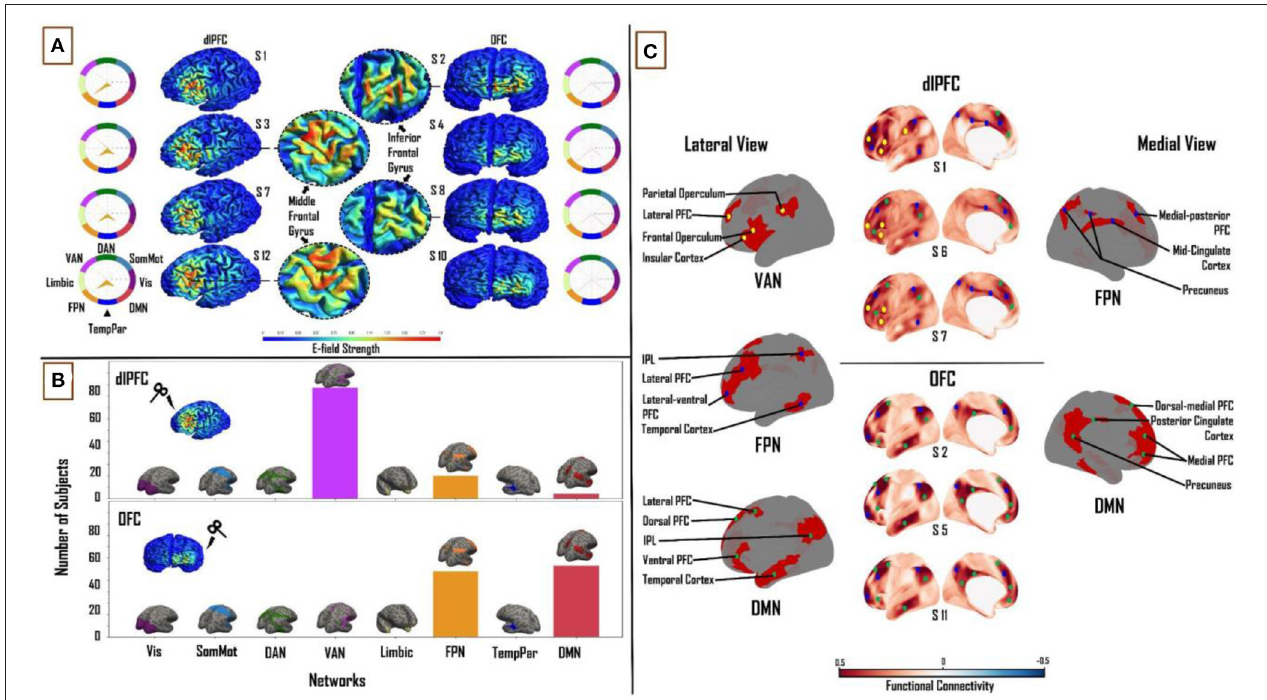
FIGURE 2 | Influence of individual cortical geometry on TMS target connectivity. (A) Individual subject E-fields for a subset of subjects highlighting anatomical differences between dlPFC and OFC E-fields. Spider plots on either side show functional network connectivity (expressed as a percentage of E-field vertices), based on the group-average FC matrix. E-field unit = V/m. (B) Summary statistics of network engagement over all 121 subjects. Top: VAN, FPN, and DMN were the main networks engaged from the dlPFC. Bottom: FPN and DMN were the main networks engaged from the OFC. Refer to Supplementary Figure 3 for a more detailed view of this panel. (C) Top: Lateral and medial view of dlPFC FC maps in subjects 1, 6, and 7, highlighting the key regions that are functionally connected across VAN, FPN, and DMN. These regions lie mainly in frontal, parietal, and temporal cortices. Bottom: Lateral and medial view of OFC FC maps in subjects 2, 5, and 11, highlighting key regions that are functionally connected across FPN and DMN. These regions lie mainly in medial-frontal, cingulate, and posterior parietal cortices. VAN, ventral attention network; FPN, frontoparietal network; DMN, default-mode